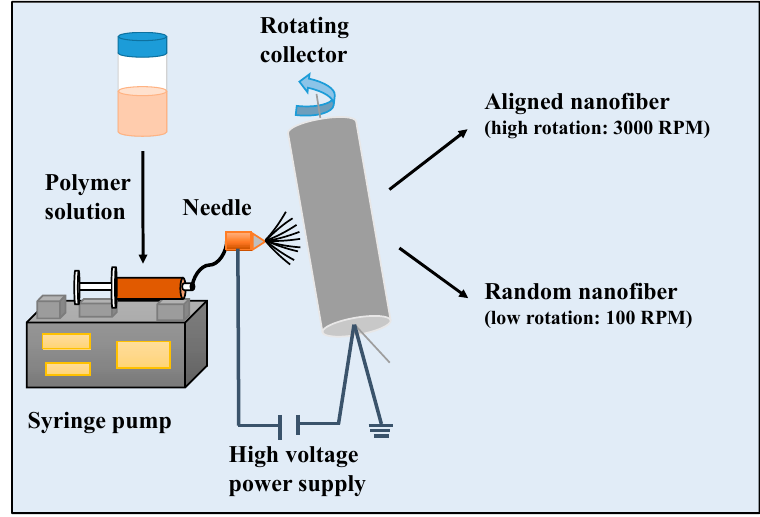
Figure 1. Schematic illustration for the fabrication of 3D PCL/Gel and PCL/Gel/HA0.5 composite scaffolds using electrospinning.